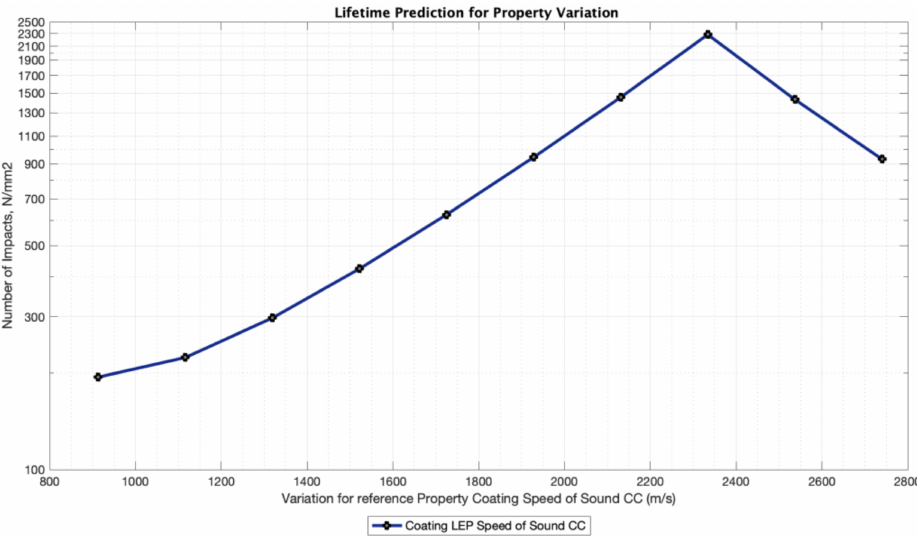
Figure 18. Incubation time estimation due to a unique variation of the coating wave speed